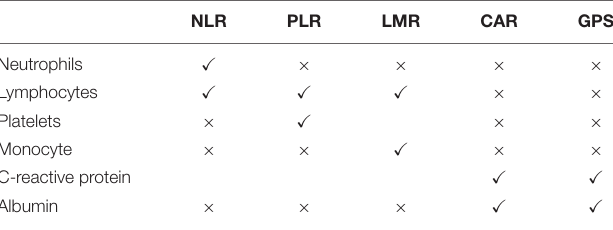
TABLE 2 | Comparison of commonly used inflammation indicators for cancer